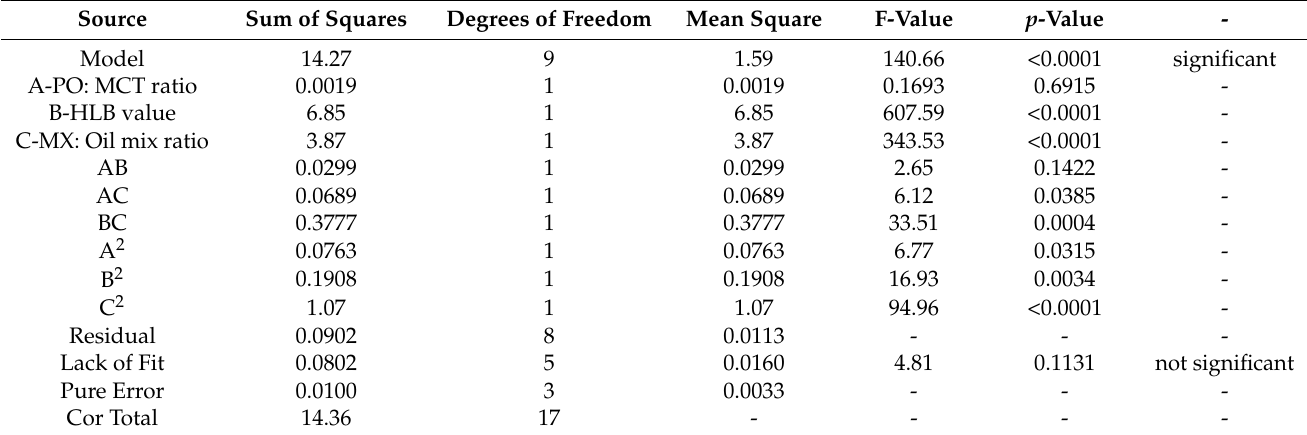
Figure 2. Design plots of the various responses: ( a ) contour plot for particle size, ( b ) response surface plot for particle size, ( c ) contour plot for stability index, ( d ) response surface plot for stability index, ( e ) contour plot for ex vivo J ss , ( f ) response surface plot for ex vivo J ss , ( g ) contour plot for ulcer index, and ( h ) response surface plot for ulcer index. Table 7. ANOVA data for ex vivo J ss in various experimental